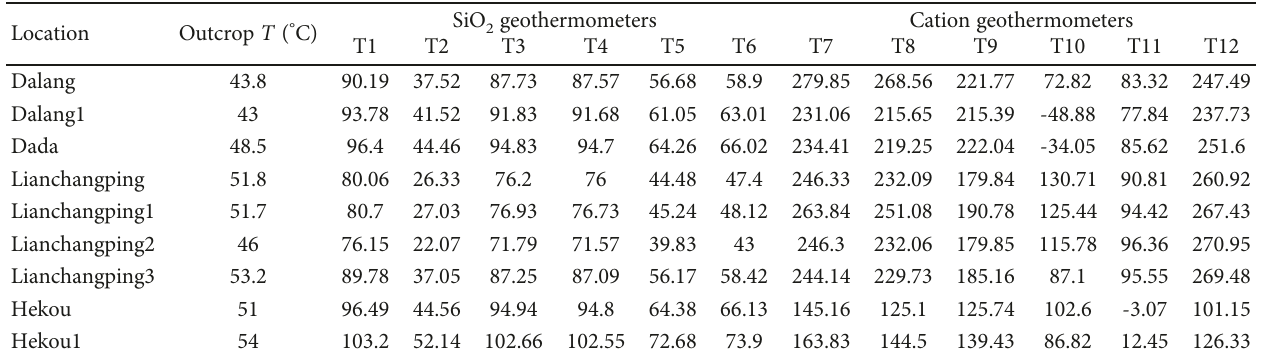
and cation geothermometers for thermal spring waters. 2